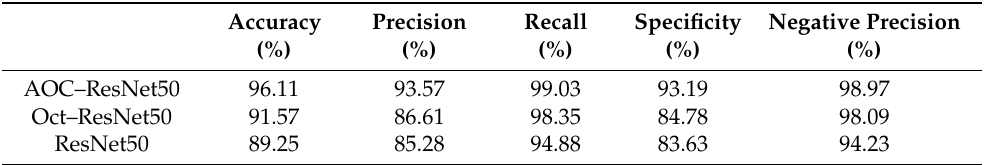
Table 6. Converter fault detection performance indices.